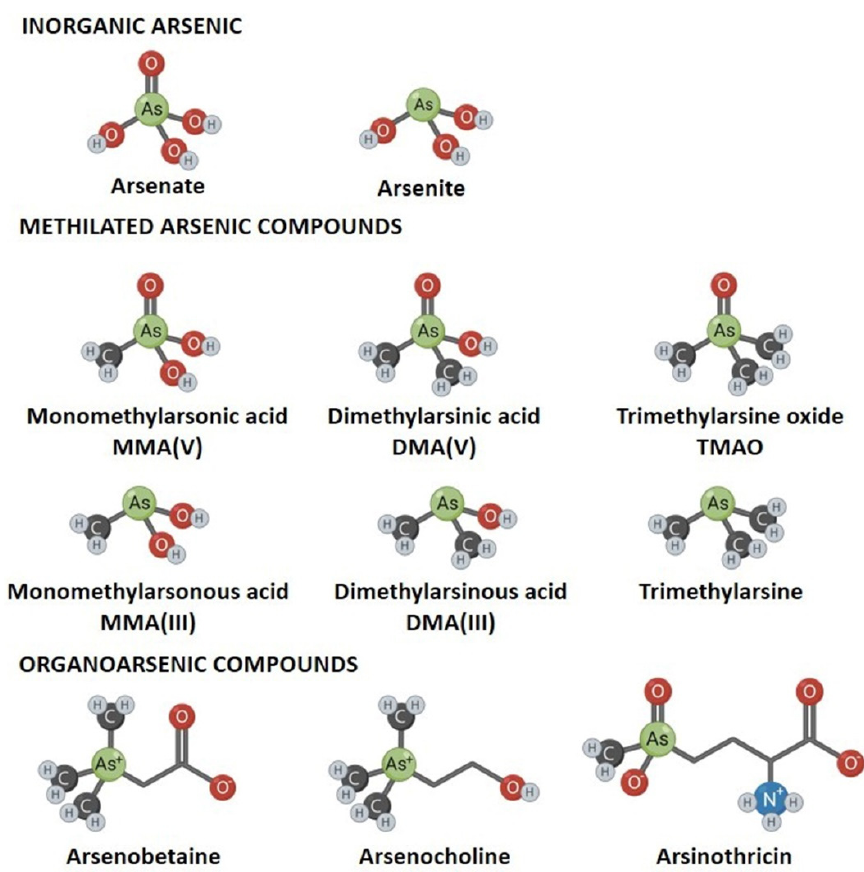
Figure 1. Main chemical forms of inorganic and organic arsenicals.